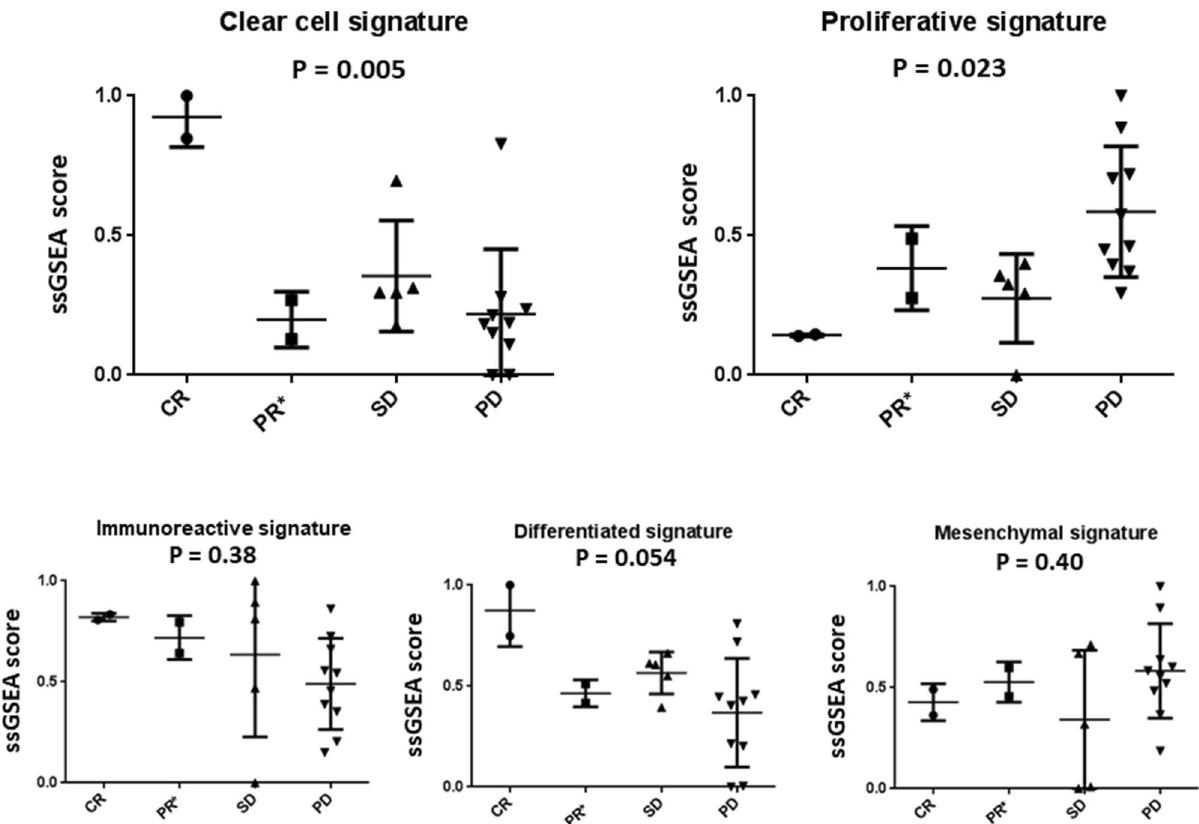
Figure 1. Significance testing of ovarian signature scores stratified by clinical response. ssGSEA was applied with gene signature sets tailored to ovarian cancer, resulting in per-signature scores normalized to the range 0–1. The clear cell signature is significant in complete responders and the proliferative signature was significantly different in patients who exhibited progressive disease. The PR* group comprises one patient classified as PR by RECIST protocols and one exceptional patient (see “Methods”). Image was created using Prism version 8.3.0 (https:// www. graph pad. com/).